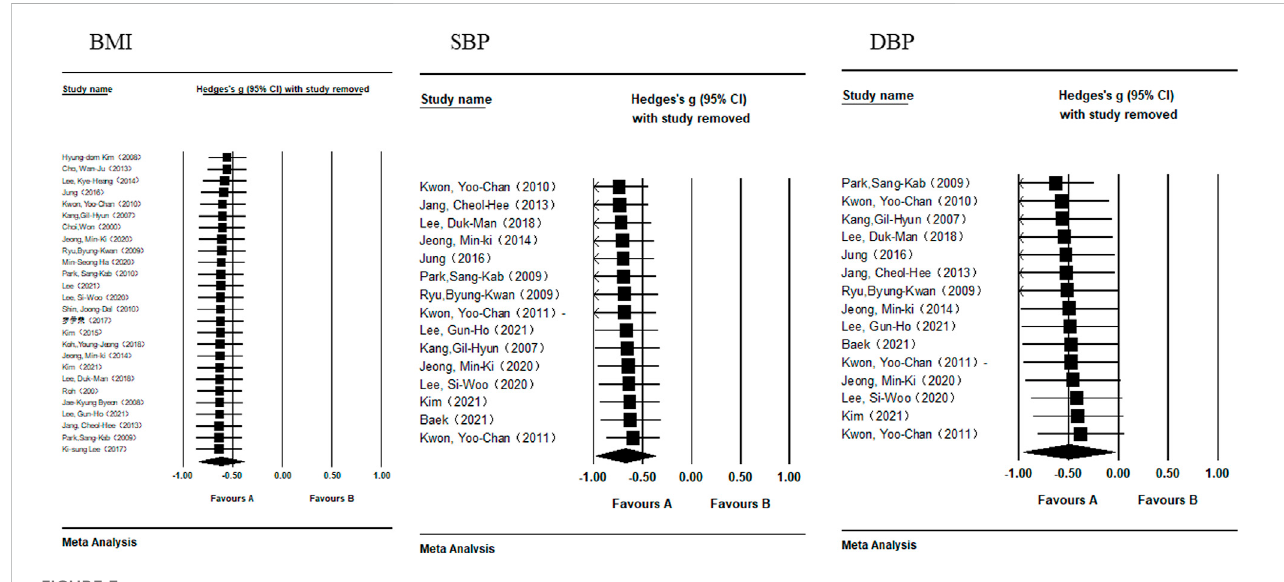
Forest map of the sensitivity analysis of BMI, SBP, and DBP.